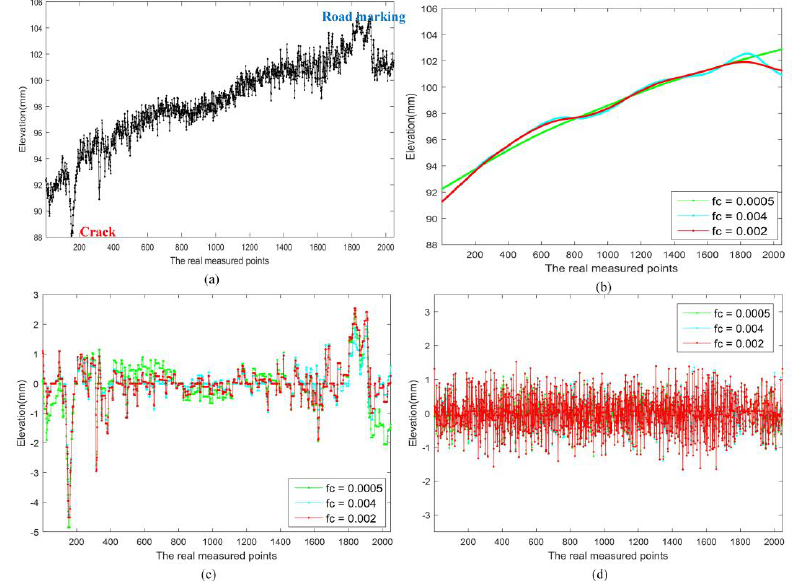
Figure 9. Pavement profile Example 2 and corresponding decomposition with different fc and fixed λ, ( a ) profile data, ( b ) low frequency component with different fc , ( c ) sparse component with different fc , and ( d ) vibration component with different fc .